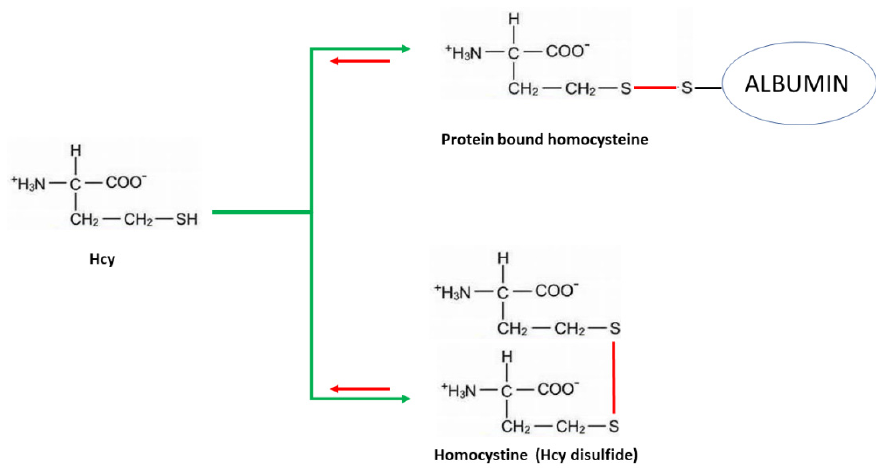
Figure 1. Various forms of Homocysteine present in vivo. The albumin adduct oxidized derivative (protein bound) is, by far, the most prevalent, while the disulfide is normally almost negligible, except under some pathological conditions (e.g., homocystinuria). Although some authors hypothesized a role for either the protein-bound oxidized or the free forms, in clinical practice, total homocysteine is detected (tHcy), i.e., the sum of all forms, since current laboratory methods have been set up by accomplishing a preliminary reducing step (red arrows) prior to analytical procedures for quantitation.